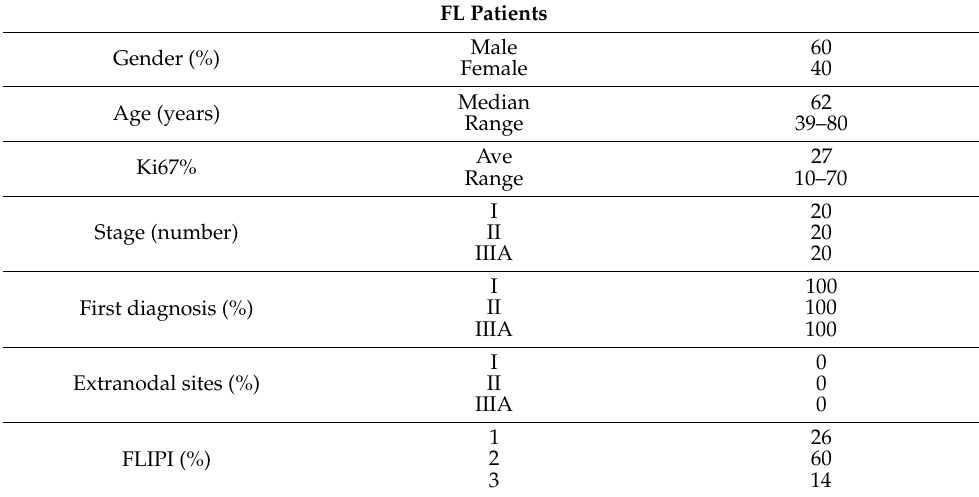
Table 1. Main clinical features of FL